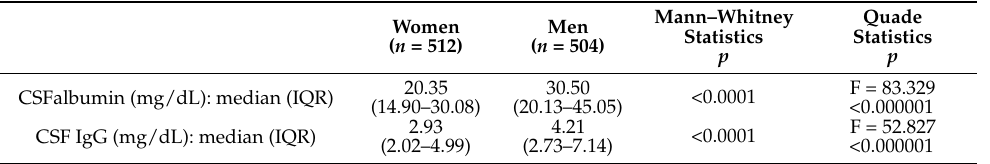
Table 3. Cerebrospinal fluid (CSF) albumin and IgG levels were compared in women and in men 260 negative for the presence of an intrathecal IgG synthesis with Quade statistics adjusting for age at 261 lumbar puncture, and serum albumin or serum IgG levels.